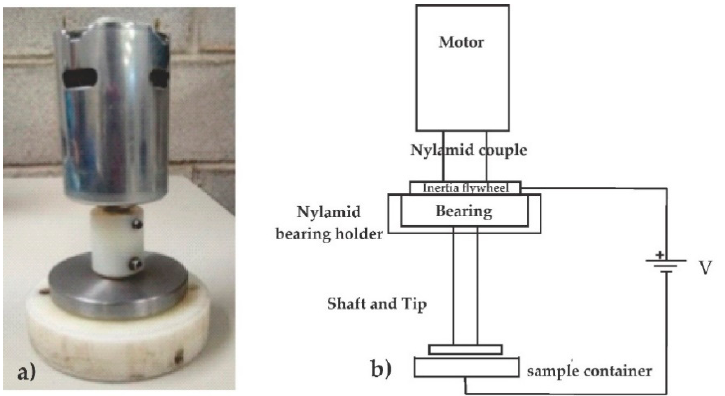
Figure13. ( a )Motorandinertiaflywheelassembly, ( b Figure 13. ( a ) Motor and inertia flywheel assembly, ( b ) electrical arrangement for electromechanical Figure 13. ( a ) Motor and inertia flywheel assembly, ( b ) electrical arrangement for electromechanical Figure 13. ( a ) Motor and inertia flywheel assembly, ( b ) electrical arrangement for electromechanical tests. tests. tests.